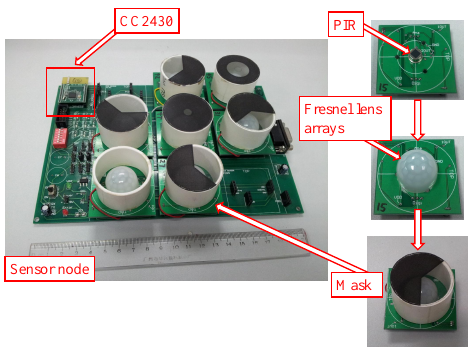
Figure 4. The wireless sensor node: there are seven PIR sensors on one sensor node. The sensor node is mounted at a height of 3m from the floor, looking down to classify human activities. Each PIR sensor is equipped with its own fresnel lens arrays and mask. The sampling frequency of PIR sensor is 25 Hz, and the resolution of the A/D converter is 8-bit. The CC2430 is the Radio Frequency (RF) transmission module based on ZigBee protocol, the transmission rate of which is 250 Kbps at 2.4 GHz.